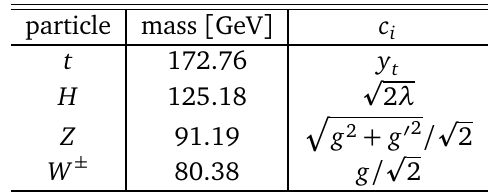
Table 1: The zero-temperature masses and the mass proportionality constants c defined in Eq. (3.1), for the most massive fields in the Standard Model. Here, y the Higgs-Yukawa coupling of the top quark, λ the Higgs self-coupling, and g and g (cid:48) the gauge couplings of the W a and B µ bosons. µ